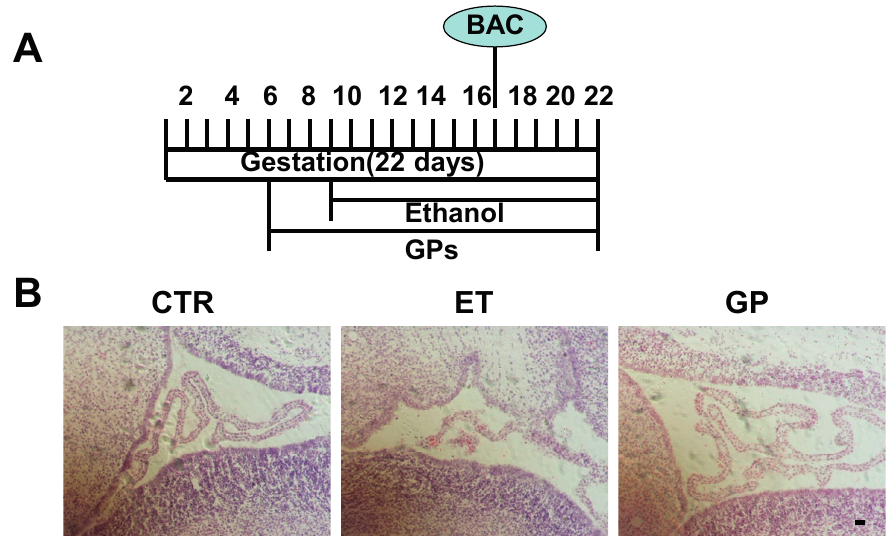
Figure 1. Gypenosides (GPs) protected the cell morphology of the subventricular zone (SVZ) in the neonatal brain of fetal alcohol spectrum disorder (FASD) rats. ( A ) Experimental scheme for the FASD rats. The rats were pre-treated with GPs (400 mg/kg/day) by gavage for G6 prior to treatment by ethanol. Ethanol (50% ( v / v )) was given by oral gavage according 4.0 g/kg body weight from G 9 until birth. The blood alcohol concentrations (BAC) was tested on G17 and ( B ) The representative HE staining for the cell morphology of SVZ. Scale bar = 200 μ